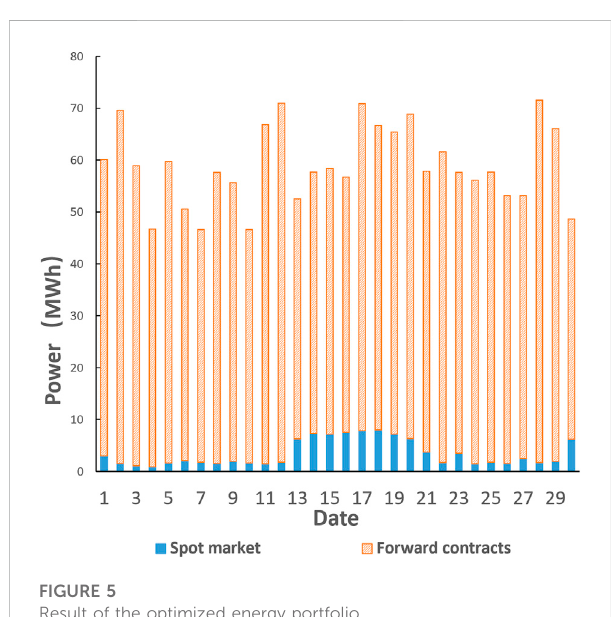
FIGURE 5 Result of the optimized energy